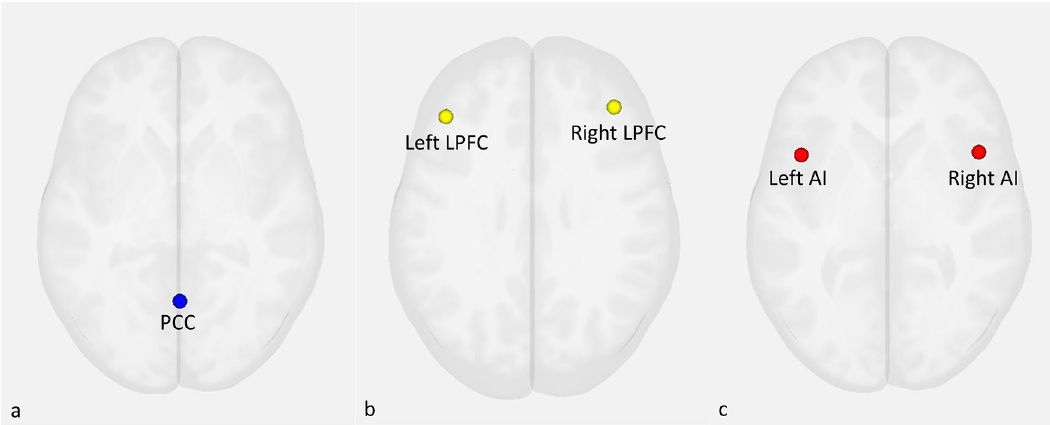
Figure 1. Seed locations for core resting state networks ( a ) default mode network (DMN) seed the posterior cingulate cortex (PCC), ( b ) cognitive control network (CCN) seed the lateral prefrontal cortex (LPFC), ( c ) salience network (SN) seed the anterior insula (AI). Based on the CONN toolbox network regions of interest for MATLAB 40